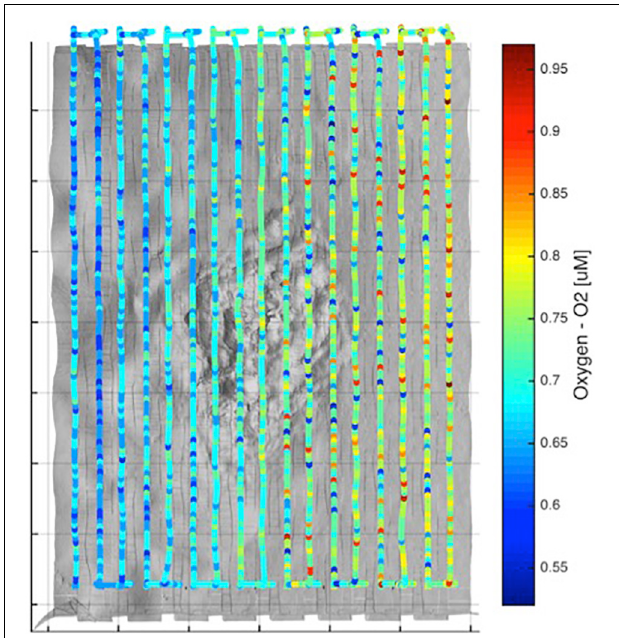
FIGURE 6 | Tracklines with dissolved oxygen concentrations overlying the Triton cold seep site. Very low oxygen levels were observed at all locations overlying the Triton cold seep site, as measured from 3 m above the seafloor during surveying. All data projected here are co-registered with the photographic and multibeam surveys shown in Figures 4 , 5 .